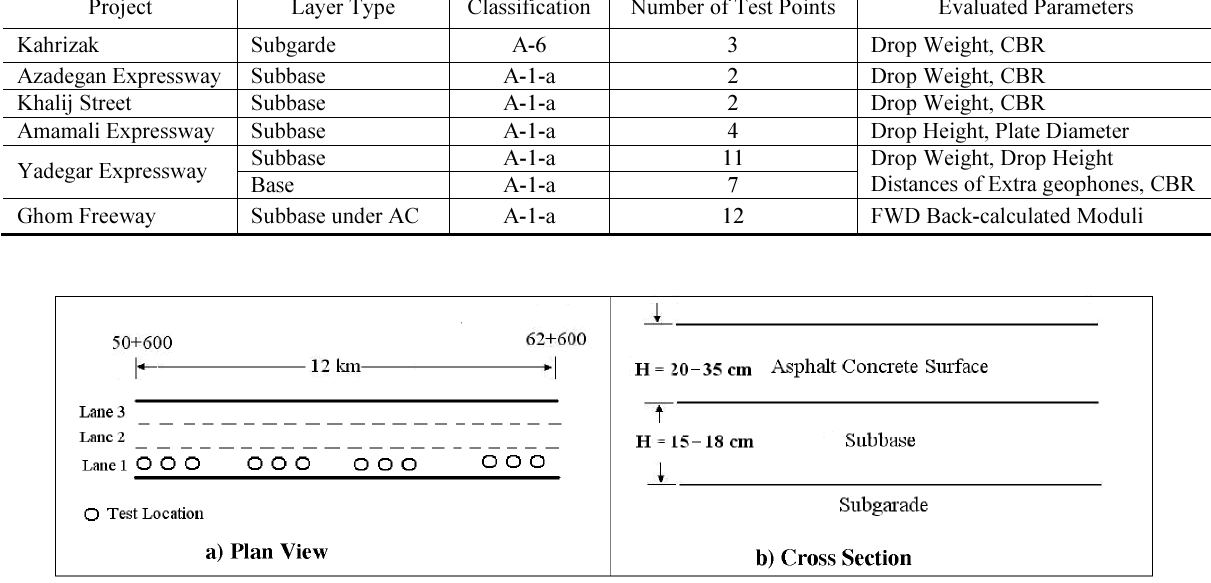
Table 1. General testing conditions and the material characteristics at various projects Project